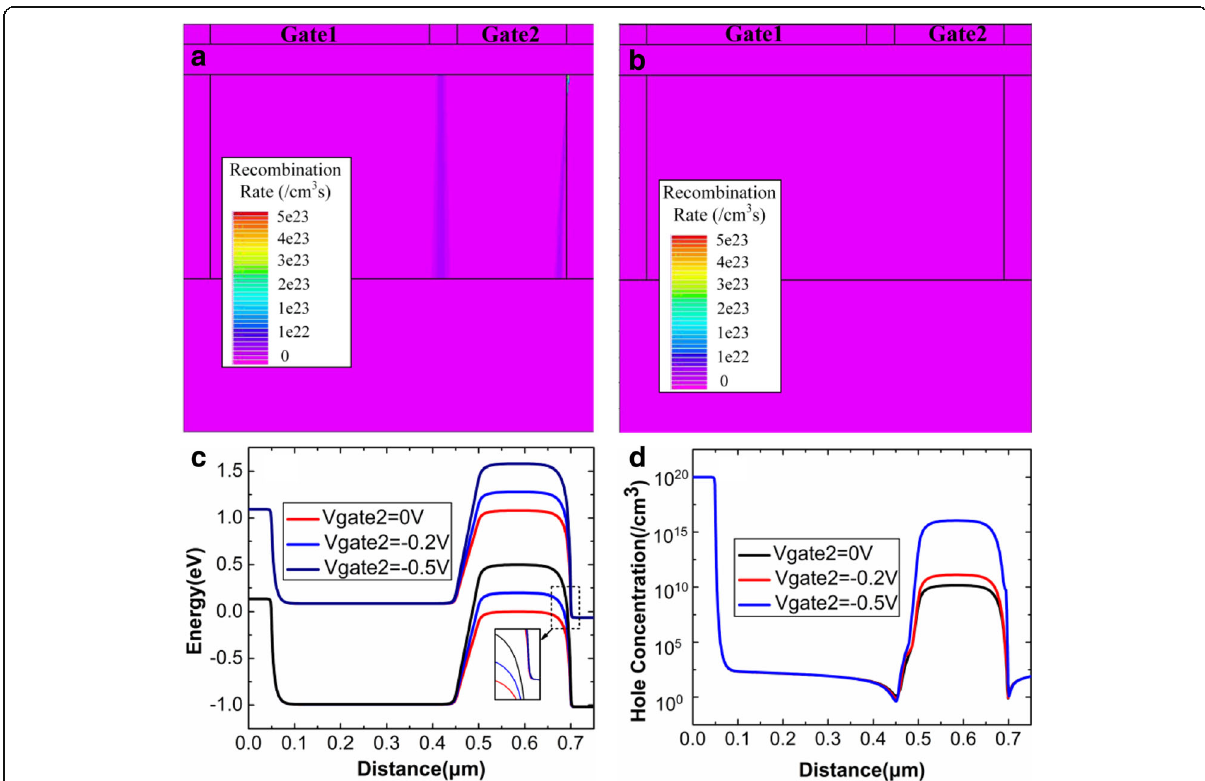
Fig. 5 Recombination rate in DG-TFET DRAM cell after holding “ 1 ” when the Gate2 voltage is a 0 V and b − 0.5 V; c energy band diagram and d hole concentration after holding “ 0 ” . a , b The recombination rate after holding “ 1 ” when the Gate2 voltage is set to 0 V and − 0.5 V, respectively. c The energy band of device from the source region to drain region. d The hole concentration of the device after holing “ 0 ” . The energy band and hole concentration is extracted at the 3 nm below the gate oxide